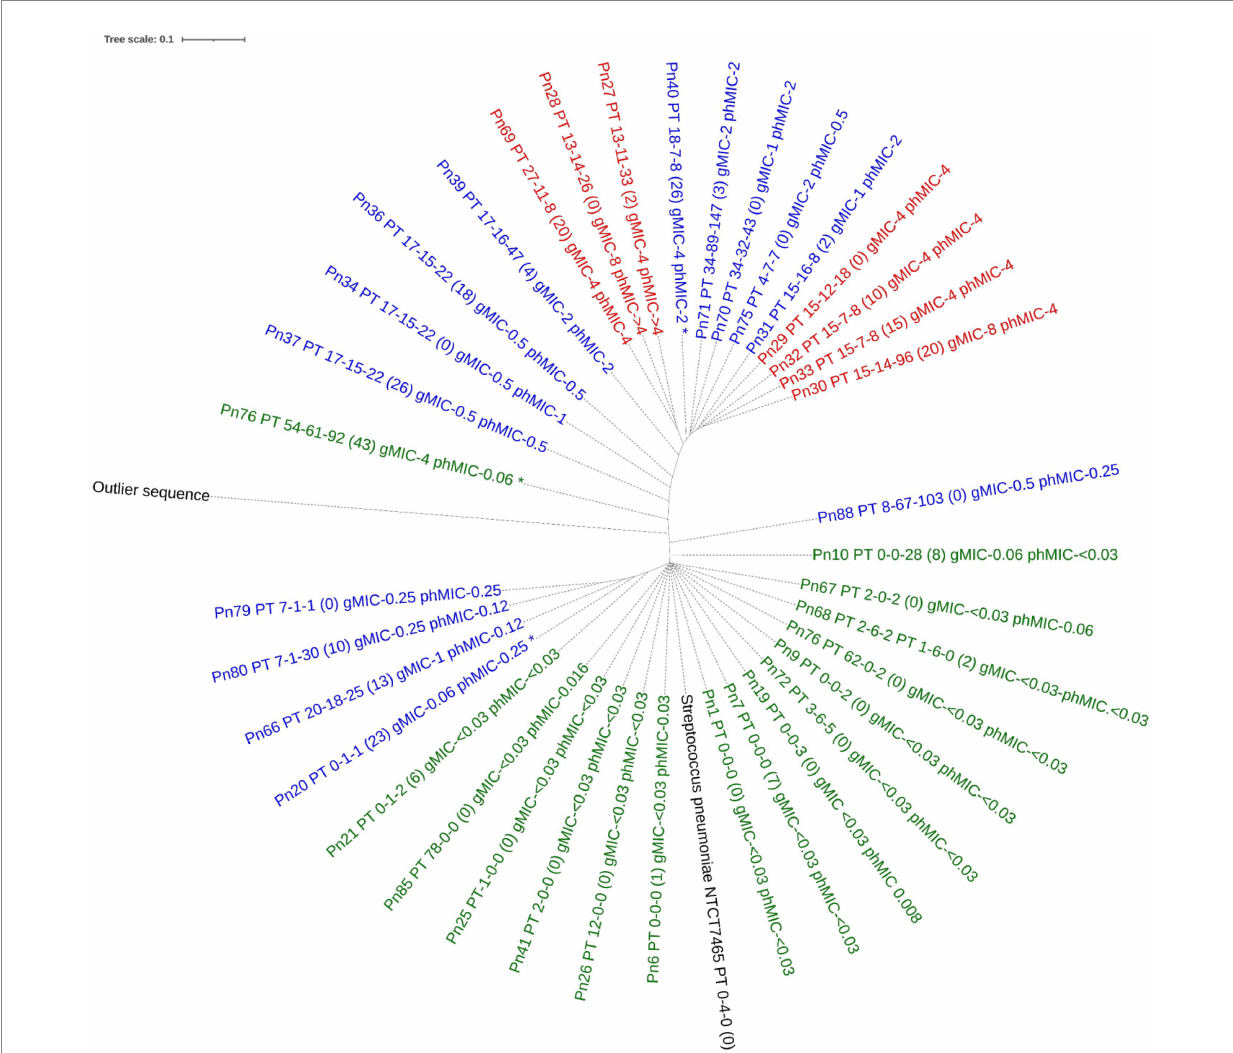
FIGURE 2 Phylogenetic tree of the concatenated amino acid sequence of PBP1a, PBP2b and PBP2x in Streptococcus pneumoniae with unique PBP-profiles. The tree was constructed using IQ-TREE software with a Blosum62 substitution model. Label contains isolate id, nearest PBP-profile (number of PBP amino acid substitutions), genotypic MIC, phenotypic MIC. Tree is colored by phenotypical susceptibility: Green is susceptible standard dosing regimen blue is susceptible increased exposure, red is resistant. The outlier sequence was constructed from Streptococcus dysgoloctiae AC2713. *indicates category